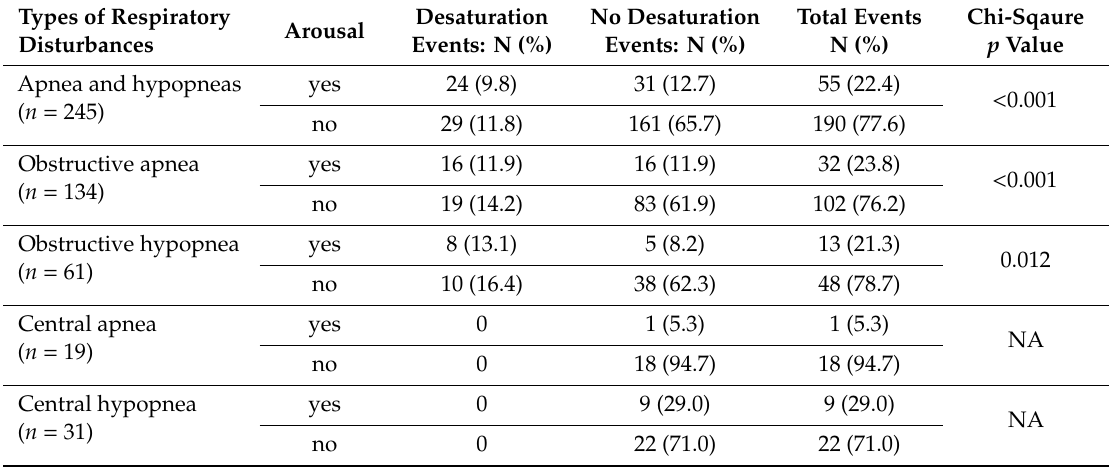
Table 3. Results of analysis of occurrence of cortical arousal in response to 245 apneas and hypopneas. Values are frequencies